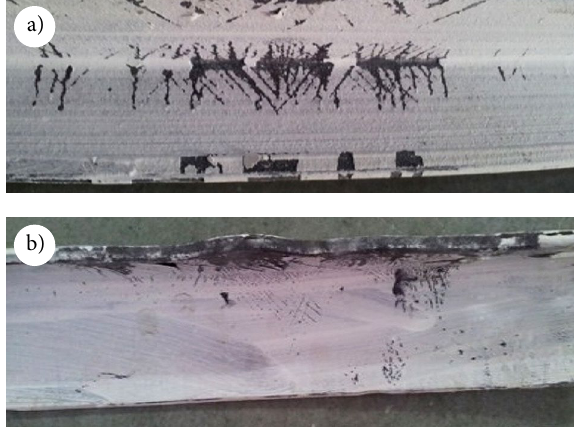
Fig.12. Failure modes and stress pattern in test specimens: